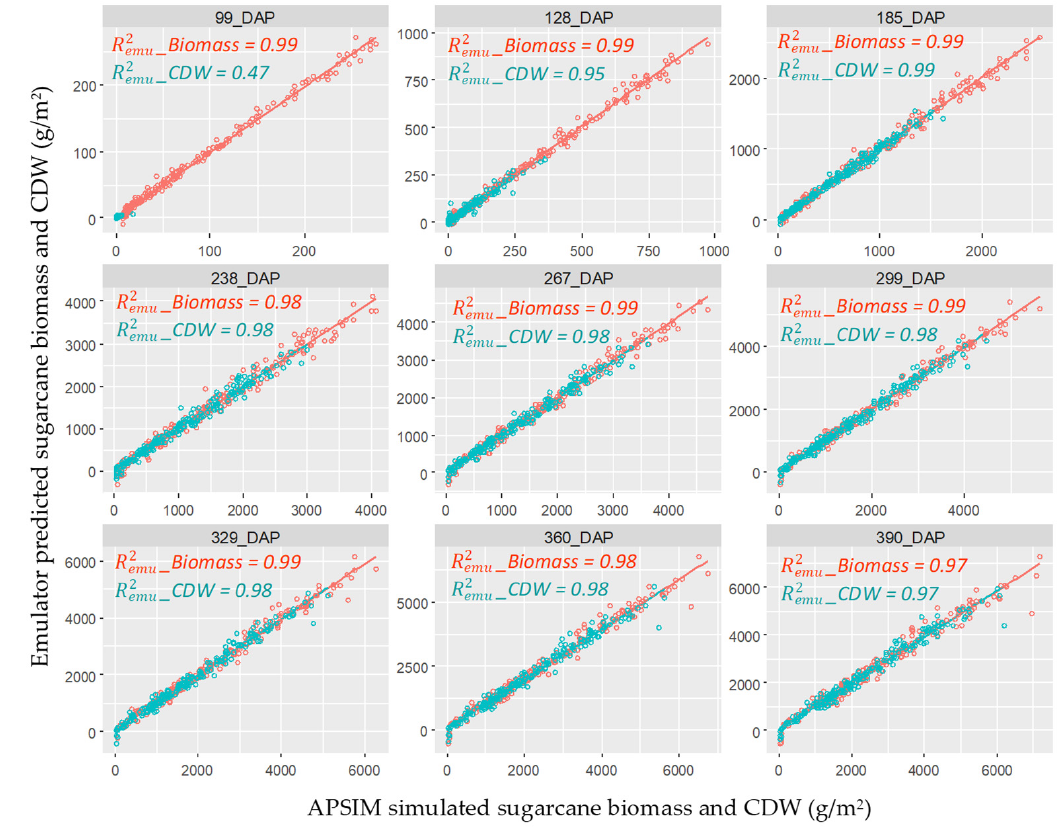
Figure 3. Relationship between APSIM-simulated values and emulator-predicted values of biomass and CDW in experiment B1 at each reporting frequency at days after planting (DAP): 99, 128, 185, 238, 267, 299, 329, 360 and 390. Solid lines indicate linear fit to the APSIM-simulated values and emulator-predicted values of biomass and CDW. CDW were calculated by using 200 data points.